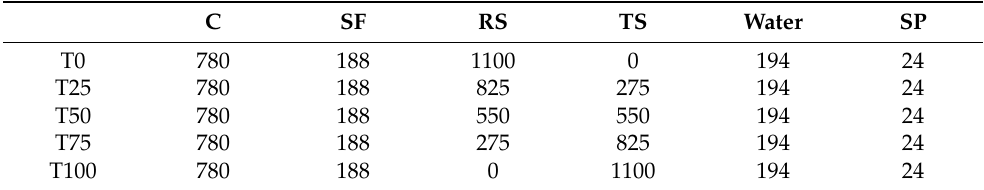
Table 3. Mix design of UHPC (kg/m 3 ).